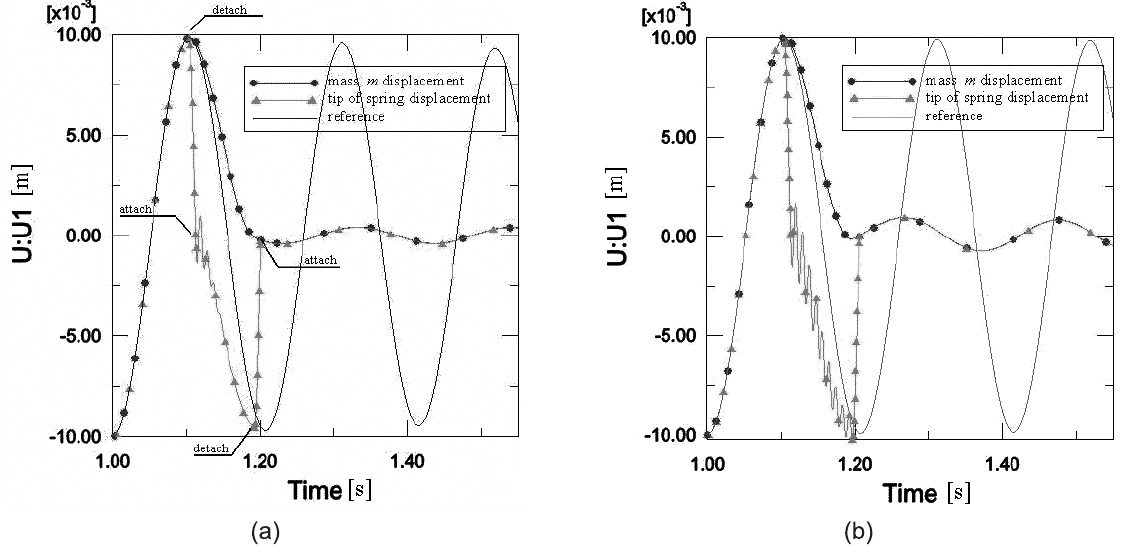
Fig. 5. Response of the system; a) 1% of critical damping b) 0.2% of critical